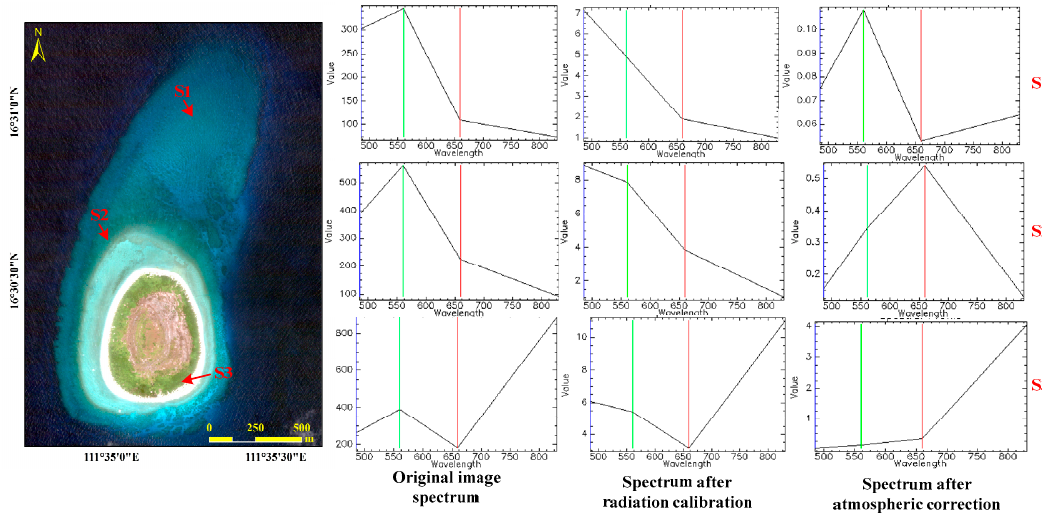
Figure 7. Result of radiation calibration and atmospheric correction.